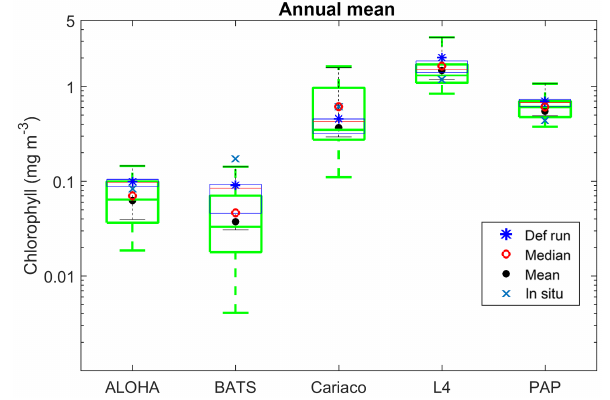
Figure 8. Annual mean of surface chlorophyll when changing only one process at a time (blue box), overlain with annual mean of all ensemble members (green box) at five oceanographic stations. En- semble mean and median plotted in the figure (shown in red open circles and black closed circles) are the from the 128 ensemble